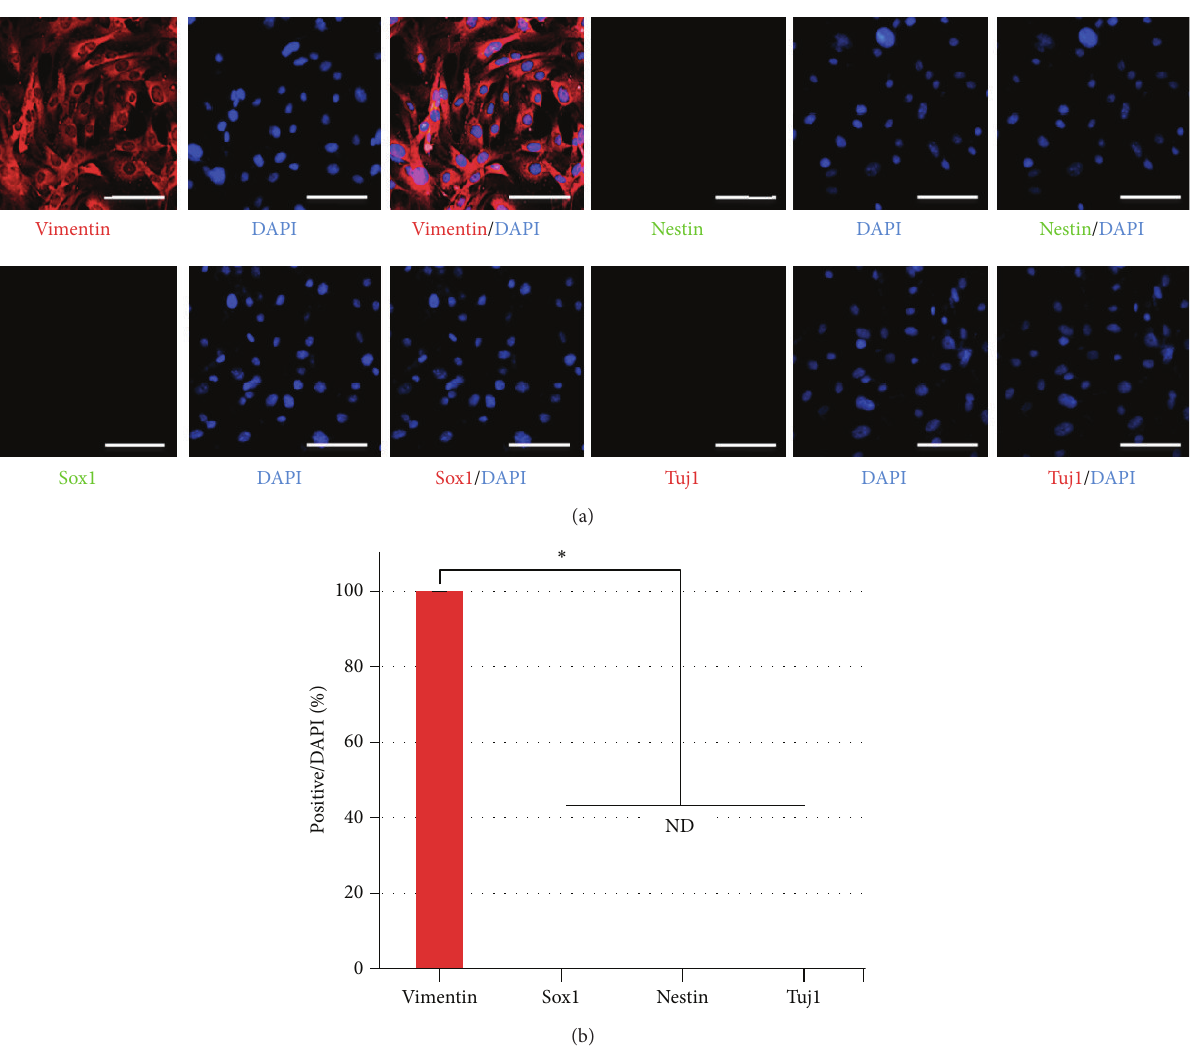
Figure1:Isolation,characterization,andconversionintoneurallineageofMEFcells.((a),(b))MEFcellsdidnotexpresstheneuronalmarkers but highly expressed the fibroblast marker. Magnification × 200; scale bar is 50 𝜇 m. Single asterisk is 𝑃 < 0.01